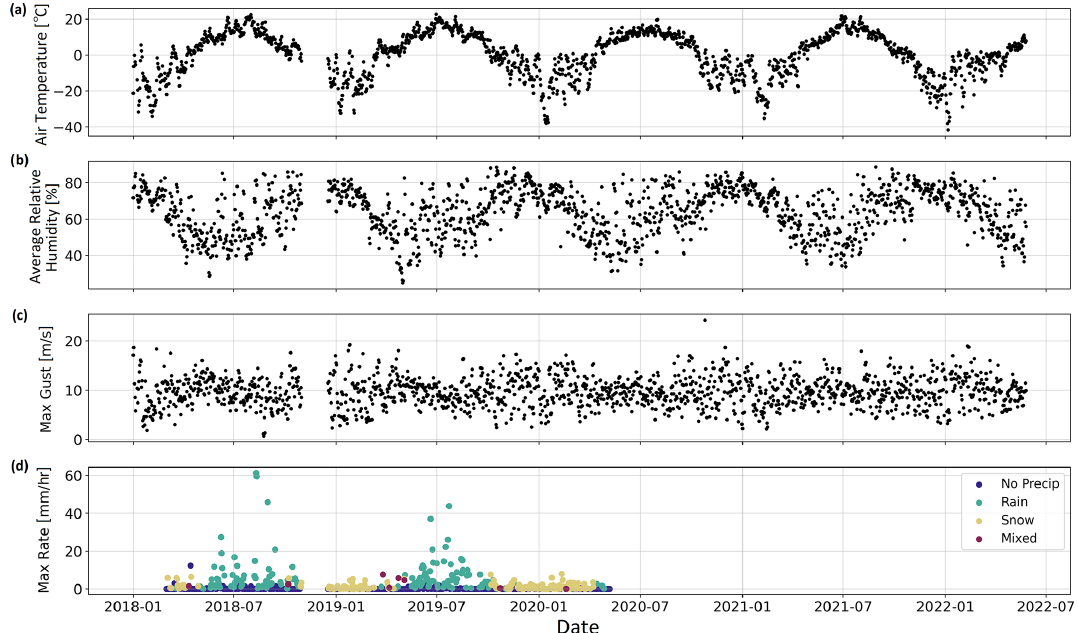
Figure 6. Surface meteorological observations conducted at the Whitehorse supersite during almost the entire study period (1 January 2018 to 1 June 2022). WXT520 daily averaged surface air temperature (a) , relative humidity (b) , and daily maximum wind speed (c) are shown. The daily maximum precipitation rate and type (d) were provided by the FS11P, which did not start recording data until February 2018 and experienced a laser failure in June 2020. The gap in observations in November 2018 was due to a power outage at the